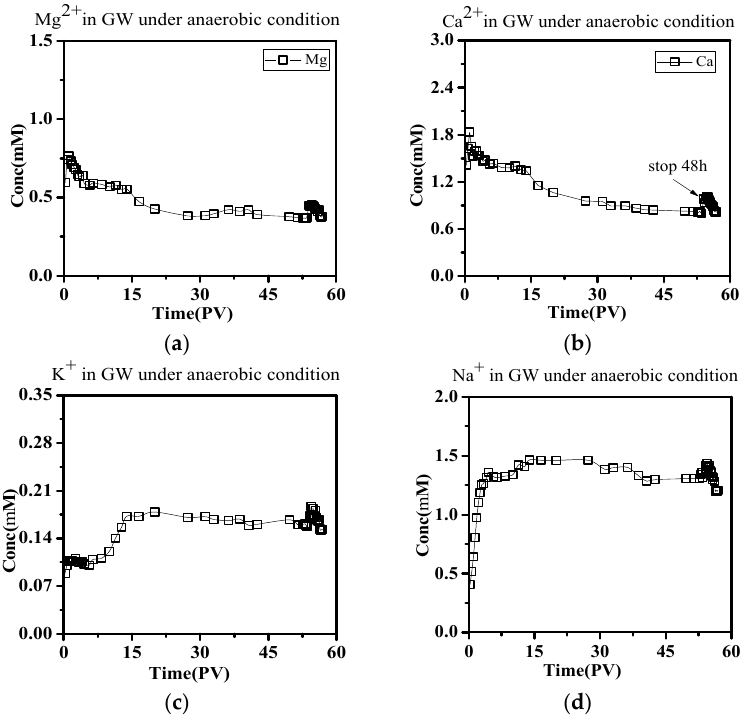
Figure 5. The The ion exchange kinetic curves of Mg 2+ ( a ), Ca 2+ ( b ), K + ( c ) and Na + ( d ) with NH 4+ in GW under anaerobic conditions.